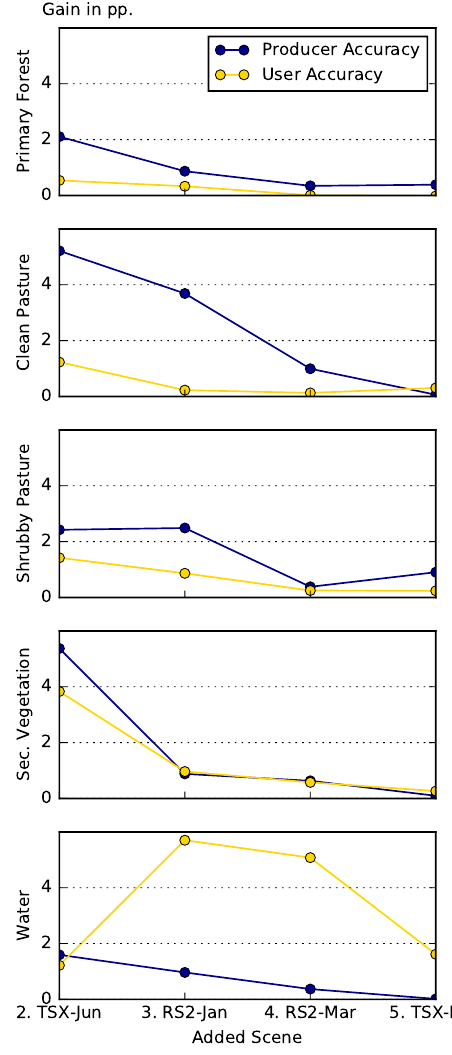
Figure 5. Gains in User and Producer Accuracy for wrapper iterations